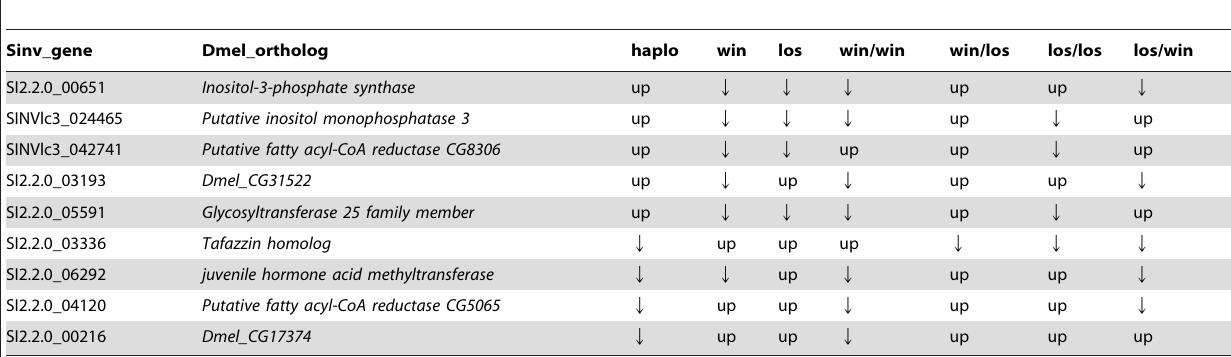
Table 2. Patterns of expression of transcripts associated with lipid metabolic process that were significantly differentially regulated in both experiment 1 and experiment 2 at FDR ,